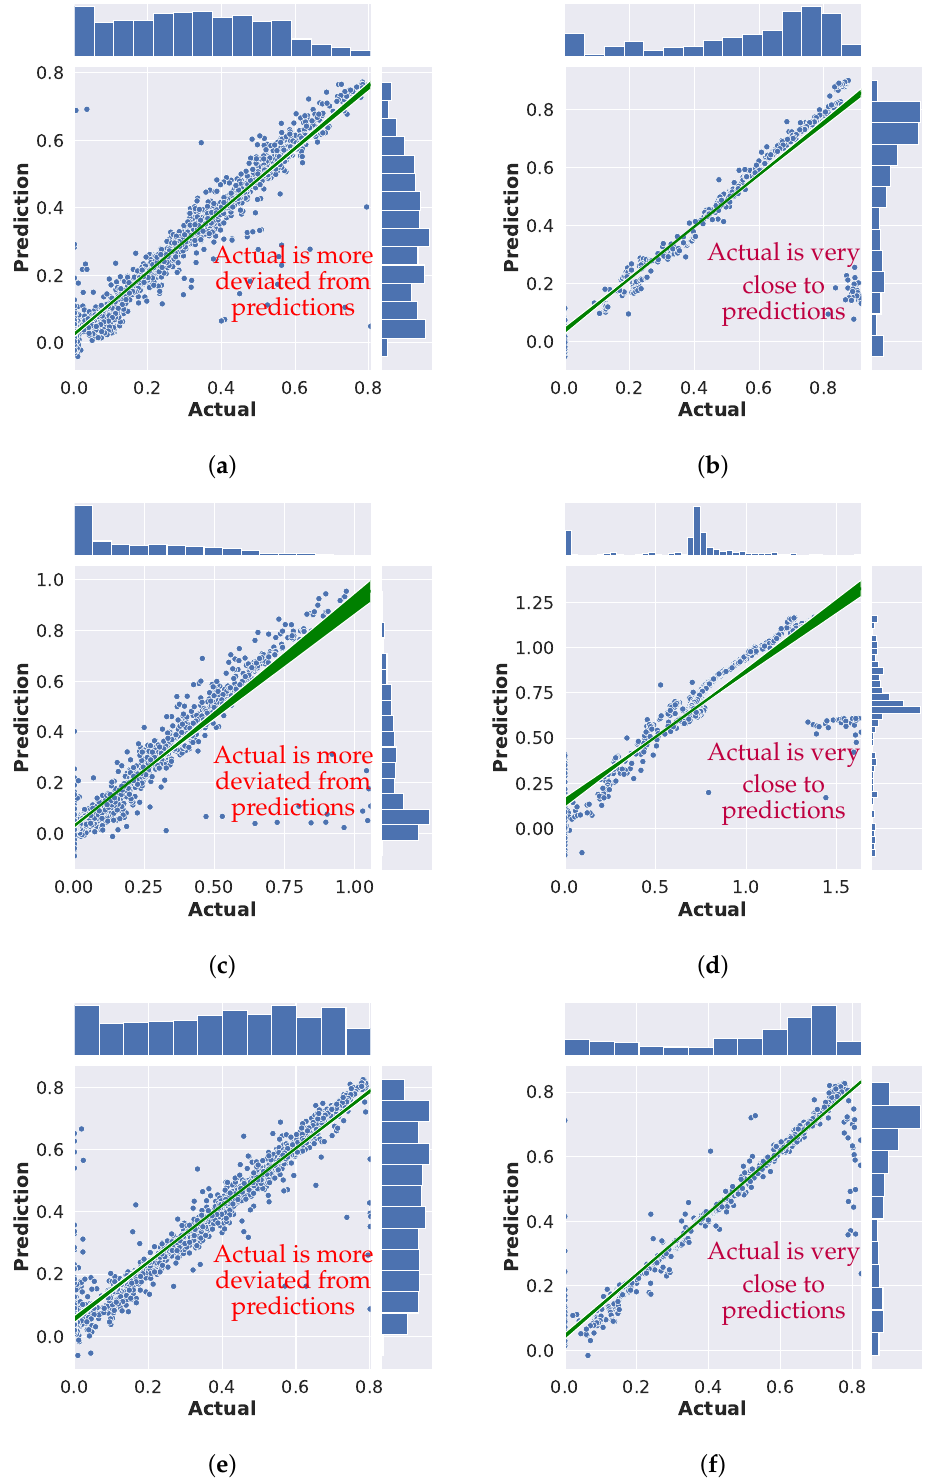
Figure 2. Parity plot showing forecast and actual clearness indices for three solar stations for high and low cloud-cover variability conditions. ( a ) Bhainsdehi (high cloud-cover variability); ( b ) Bhains- dehi (low cloud-cover variability); ( c ) Osmanabad (high cloud-cover variability); ( d ) Osmanabad (low cloud-cover variability); ( e ) Khaga (high cloud-cover variability); ( f ) Khaga (low cloud-cover